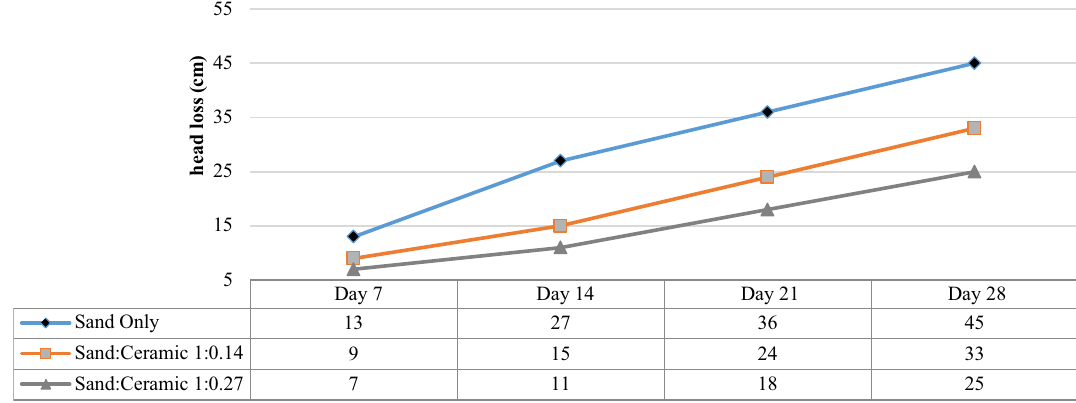
Fig. 17 The relation between the head losses in run 4